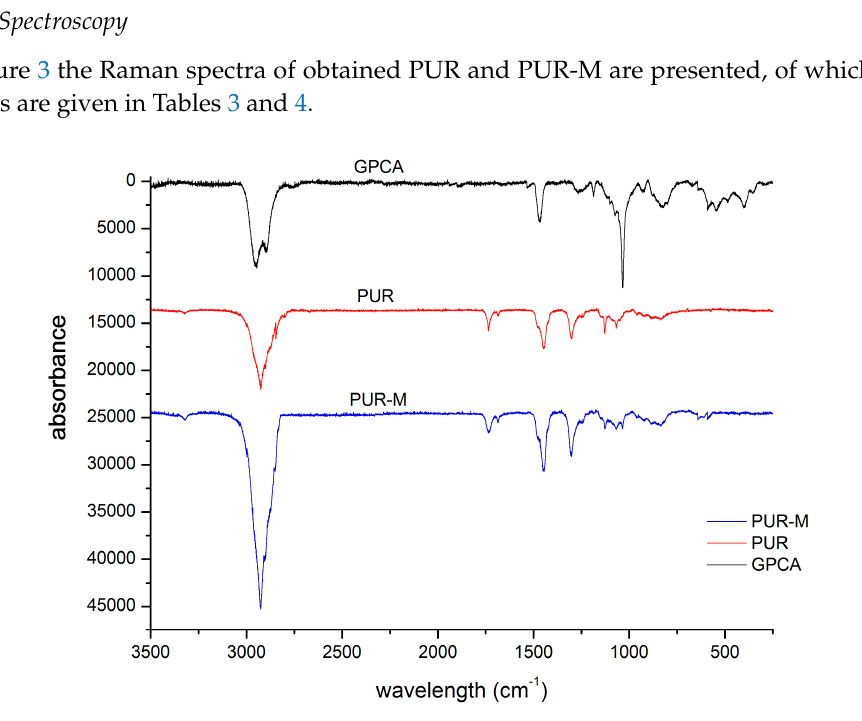
Figure 3. Raman spectra of PUR and PUR-M. Table 3. Raman spectra band assignments for obtained PURs.